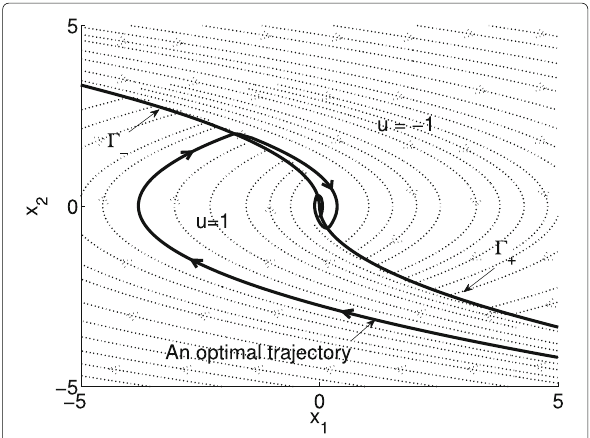
Fig. 9 Optimal synthesis for the Fuller’s